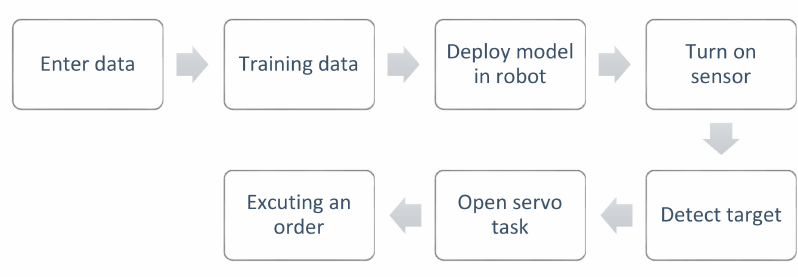
Figure 9. The workflow of the test system.